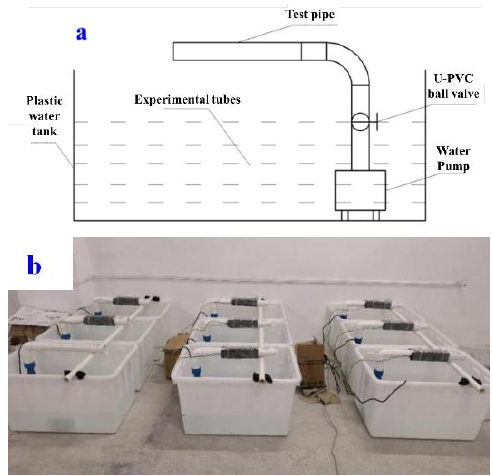
Fig. 5. Diagram of the indoor test model (a: diagram; b: picture).